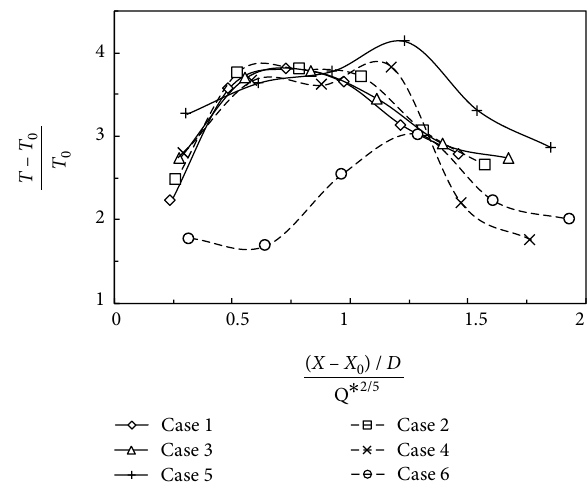
Figure 7: The dimensionless temperature distribution on the flame trajectory.